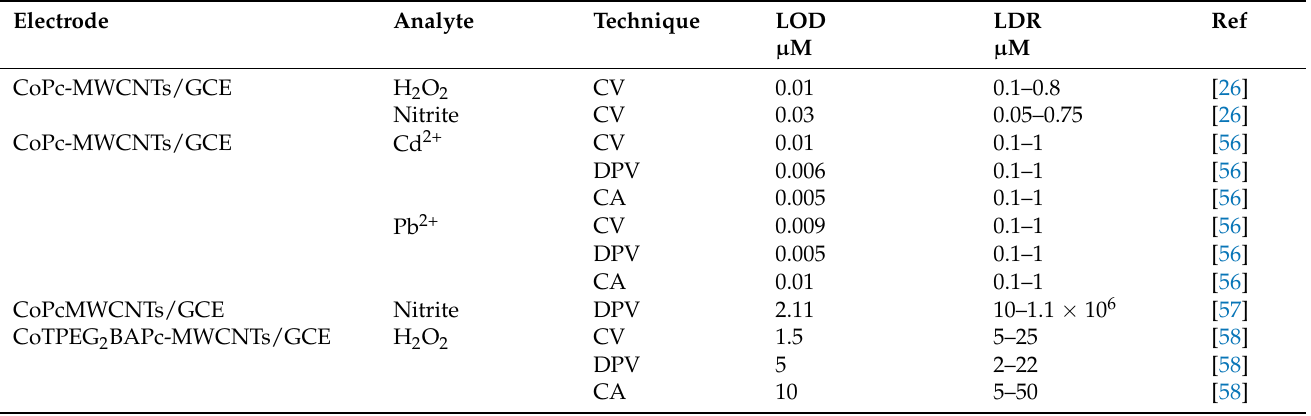
Table 2. Detection of hydrogen peroxide, nitrite, and heavy metals with CoPc-MWCNTs modified